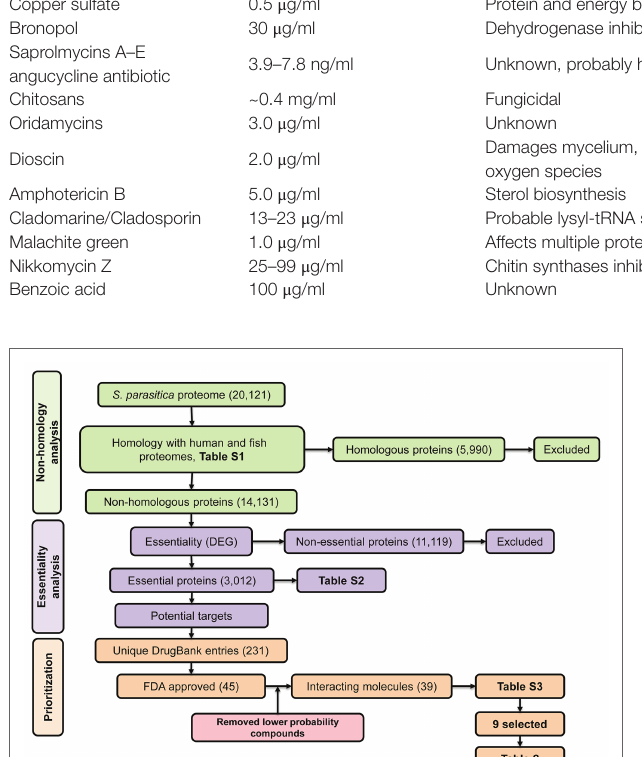
FIGURE 1 | Schematic representation of the subtractive proteomics approach used in the present study. The whole proteome of Saprolegnia parasitica was searched using blastp (E-value < 1.0E-03, bitscore > 100) against human and fish proteomes followed by Database of Essential Genes (DEG) and finally, against DrugBank database for identification of food and drug administration (FDA)-approved inhibitor compounds.